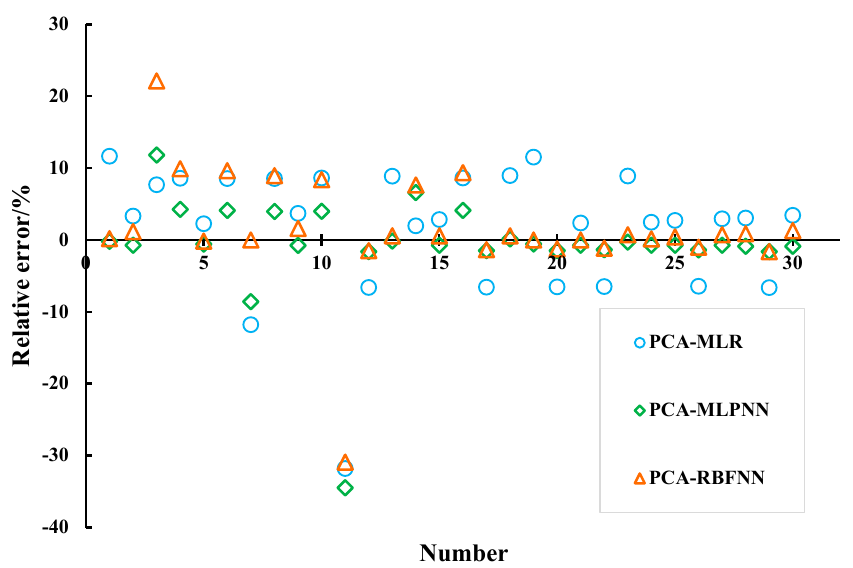
Figure 5. Comparison of model prediction results.